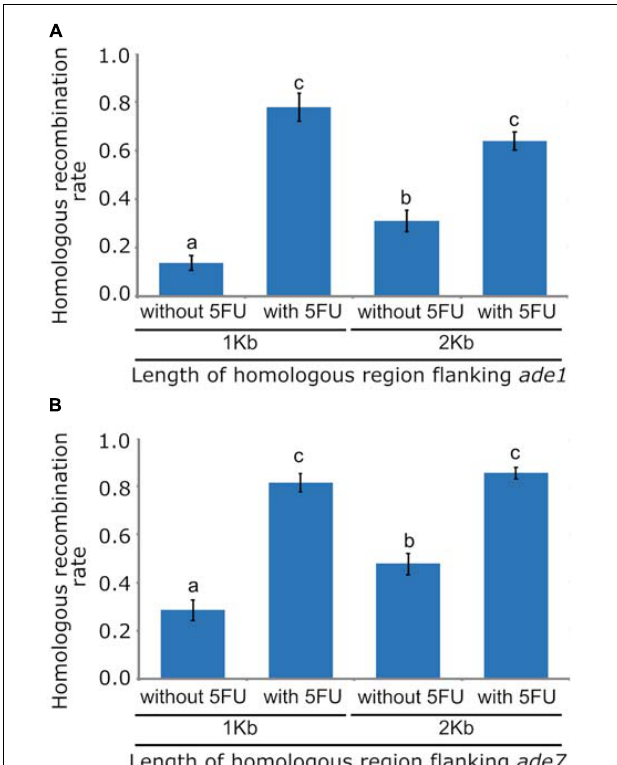
FIGURE 2 | Bar graphs showing the effects of using 1 Kb or 2 Kb of homologous sequence flanking targeted loci, and applying counterselection with 5-Fluoro-2 (cid:48) -deoxyuridine, on the frequency of homologous recombination (HR) in Ophiostoma novo-ulmi strain 174_68 (cid:49) mus52 . (A) HR frequency for targeted locus ade1 . (B) HR frequency for targeted locus ade7 . Standard error bars are displayed at the top of each bar. Different letters above each bar indicate statistically significant differences ( p < 0.05) according to the sequential Bonferroni method for error